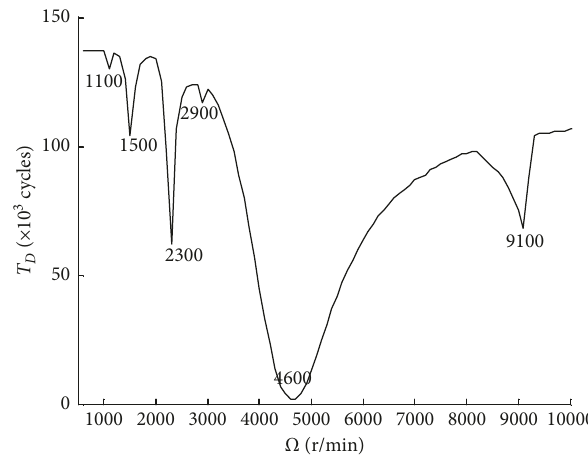
Figure 7: Fatigue degradation life versus rotation speed with